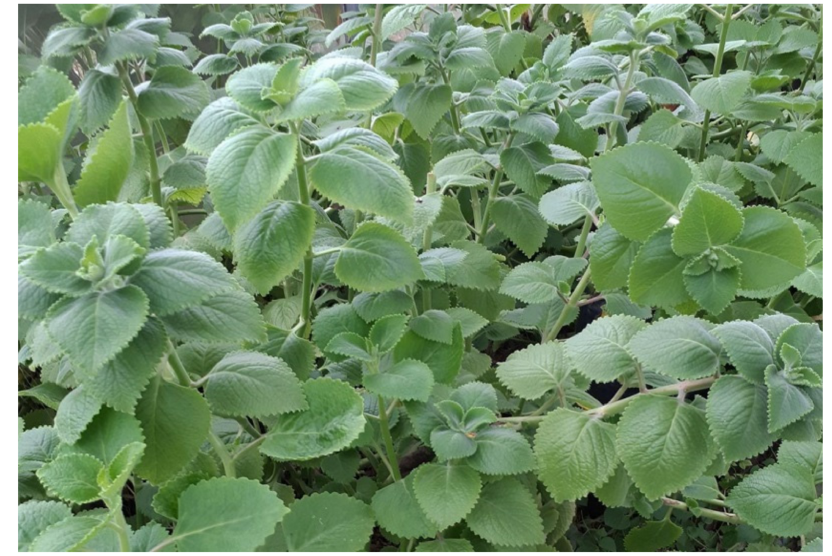
Figure 1. Plectranthus amboinicus (Lour.) Spreng. used in this